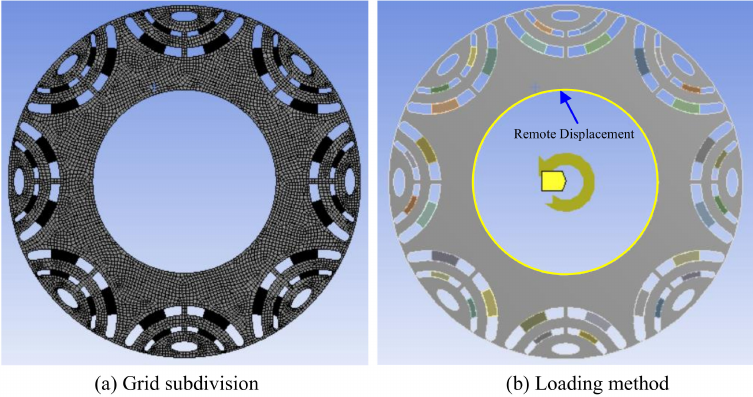
Figure 4. Settings in mechanical simulation: ( a ) grid subdivision; ( b ) loading